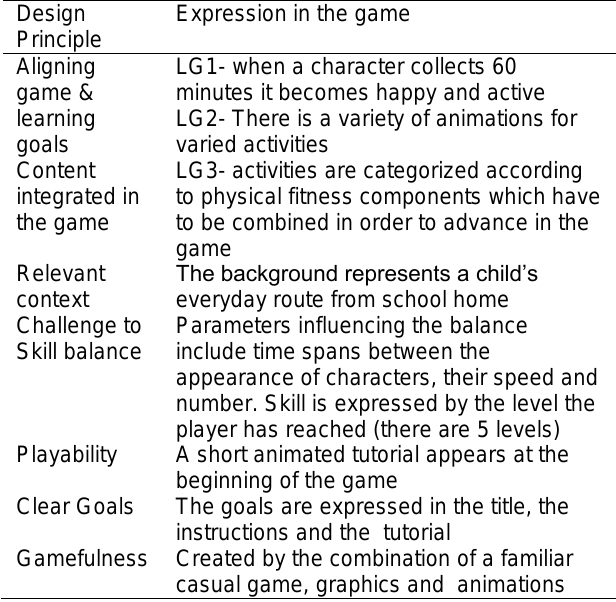
Table 2: Expression of Design principles in